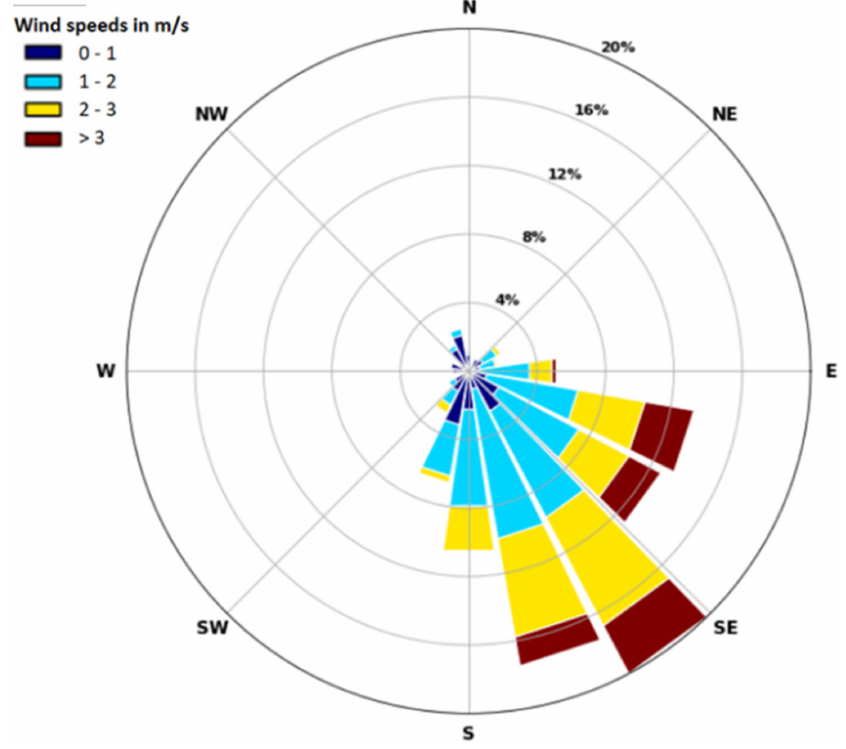
Figure 13. Wind rose showing the wind speed and wind direction measured with the TriSonica Mini during the horizontal flight performed at 13:41 local time on 23 January